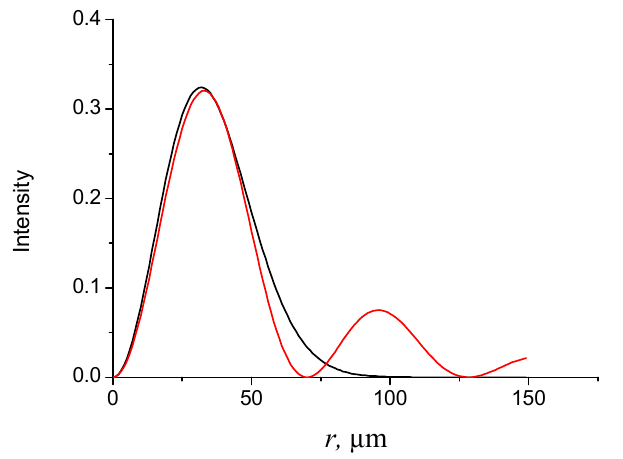
Figure 7. Intensity profiles of Gaussian (black line) and BG (red line) beams. 𝑎 (cid:2868) = 45 μ m; 𝑤 (cid:2868) = 200 μ m, 𝑤 (cid:3003) = 70 μ m.